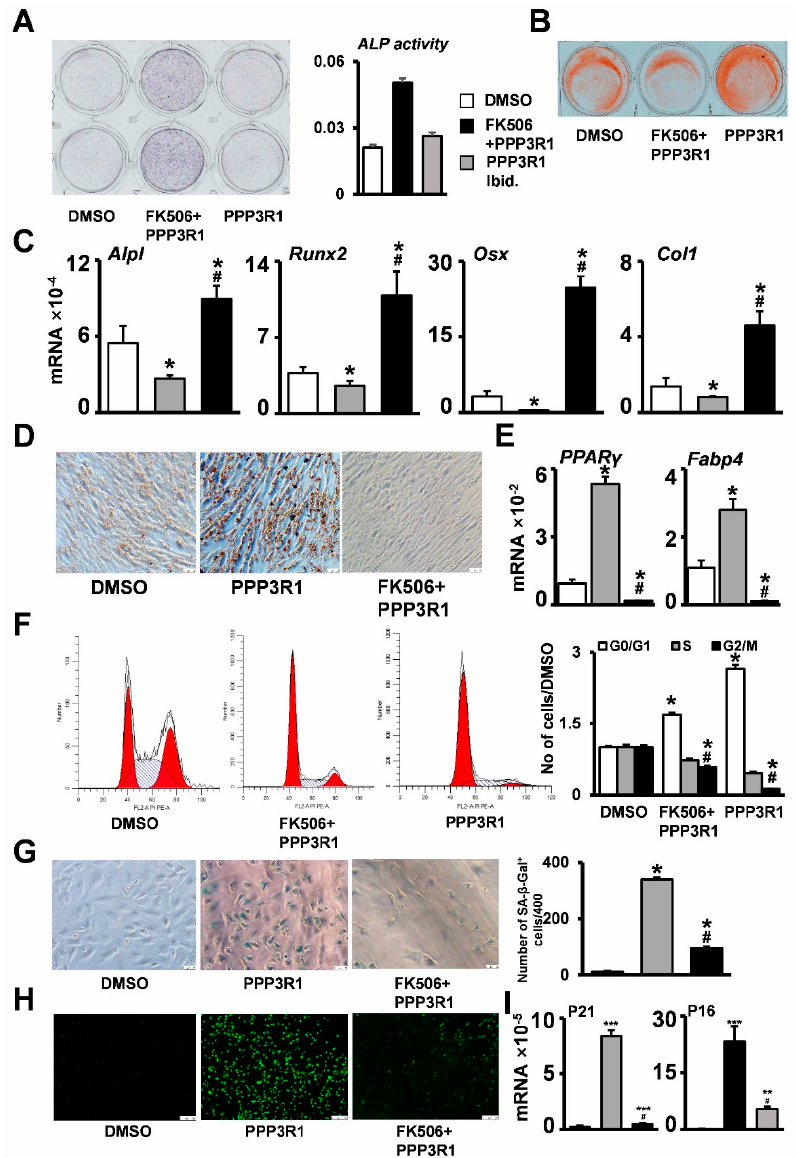
Figure 3. PPP3R1 inhibition enables C3H10T1/2 escape from senescence. Osteogenic differentiation ability was evaluated by ( A ) ALP staining, ( B ) alizarin red staining, and ( C ) qPCR in C3H10T1/2 cells treated with PPP3R1 recombinant protein as well as FK506. Changes in adipogenic differentiation ability were detected by ( D ) oil red O staining as well as ( E ) qPCR. Changes in cellular senescence sta- tus were assessed by ( F ) cell cycle assays, ( G ) β -galactosidase staining, ( H ) ROS staining, and ( I ) qPCR assays. * # p < 0.05. ** p < 0.01. *** p < 0.001. ( F ) red areas: G0/G1 and G2 phase; ( F ) shadow areas: S phase (Scale bars: ( A ) 100 µ m, ( B ) 100 µ m, ( D ) 25 µ m, ( G ) 50 µ m, ( H ) 250 µ